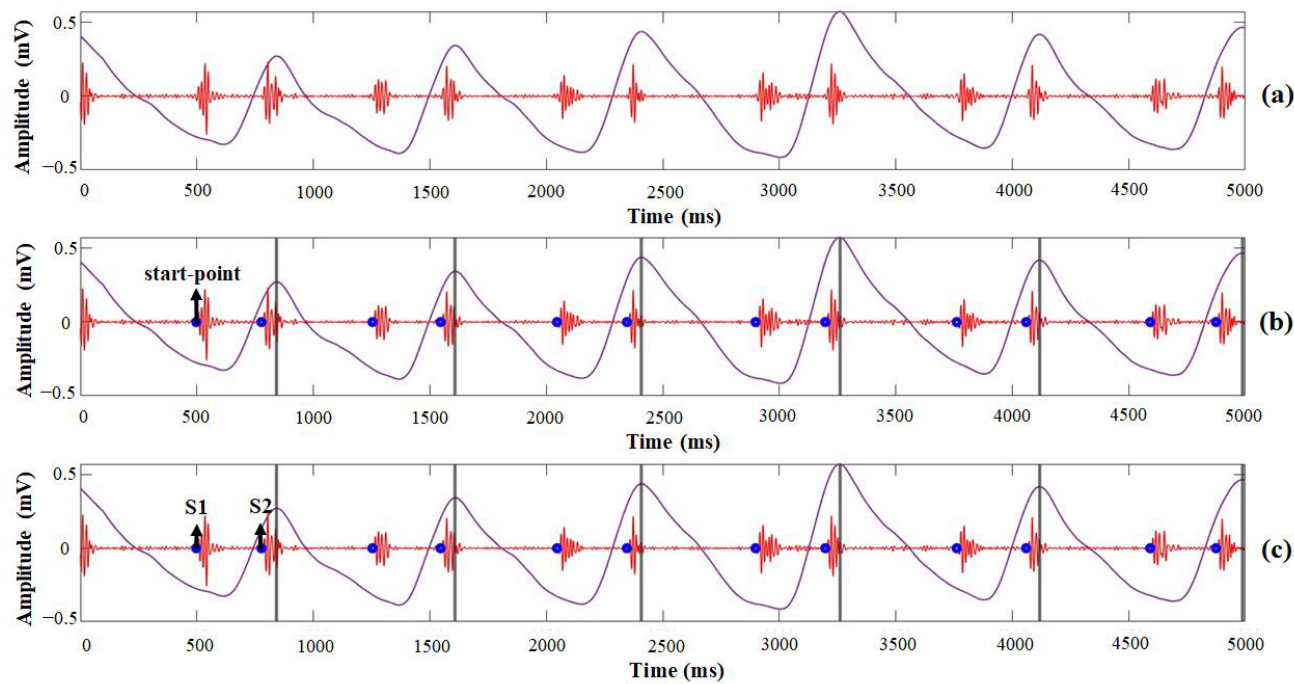
Figure 13. Example of procedures and results of automatic S1 and S2 heart-sound identification by the developed algorithm using a PPG signal reference: ( a ) recorded PCG and PPG; ( b ) detected start-points of heart sound and peak of PPG; ( c ) identified S1 and S2 heart sounds.